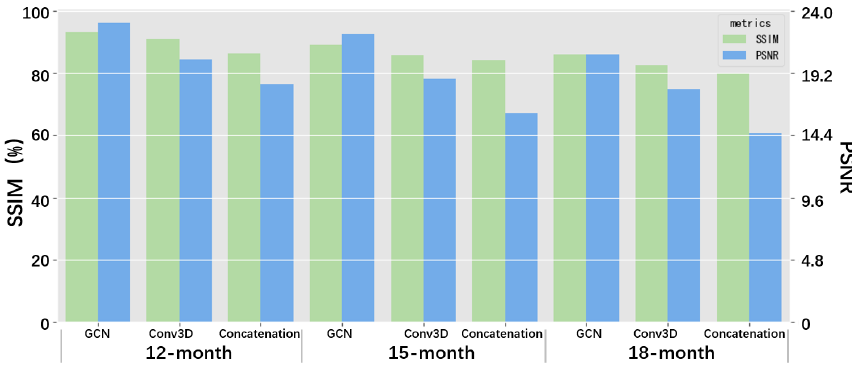
Figure 12. The performances of the ENSO-ASC when replacing the multivariate air–sea coupler with other deep learning structures.